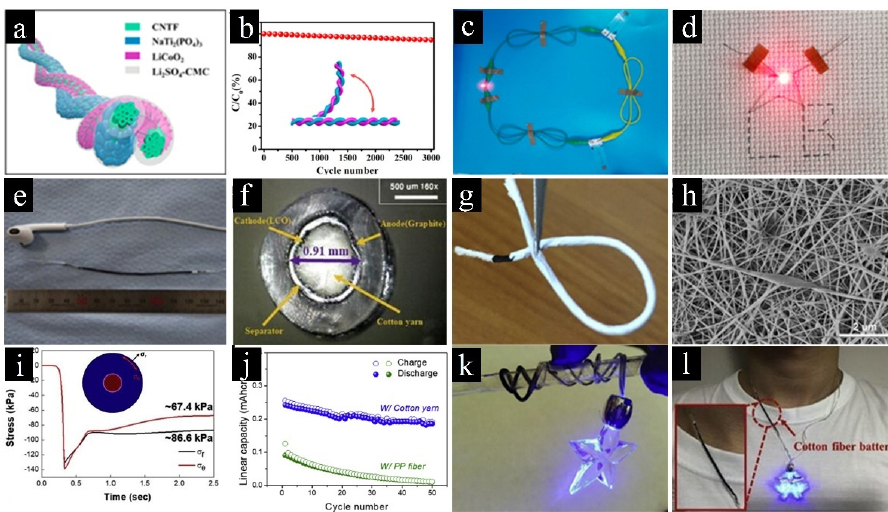
Figure 6. ( a ) Schematic of the assembled twisting LIB. ( b ) Cycle stability at 90° bending of the LIB. Images of ( c ) the LIBs in series lighting an LED, and ( d ) the LED powered by the LIB textile. ( a – d ) Reprinted with permission from [57]. Copyright American Chemical Society Publisher, 2020. ( e ) Image of the 9 cm fiber battery. ( f ) Cross-section of the as-assembled fiber-shaped battery. ( g ) Image of a PVDF separator coated on the electrode. ( h ) SEM image of the PVDF film. ( i ) The development of stress in the fiber surface during expansion. ( j ) Cycle stability comparison of cotton fiber battery and polypropylene fiber battery. ( k , l ) Images of the as-assembled fiber battery application. ( e – l ) Reprinted with permission from [58]. Copyright Elsevier Publisher, 2019.